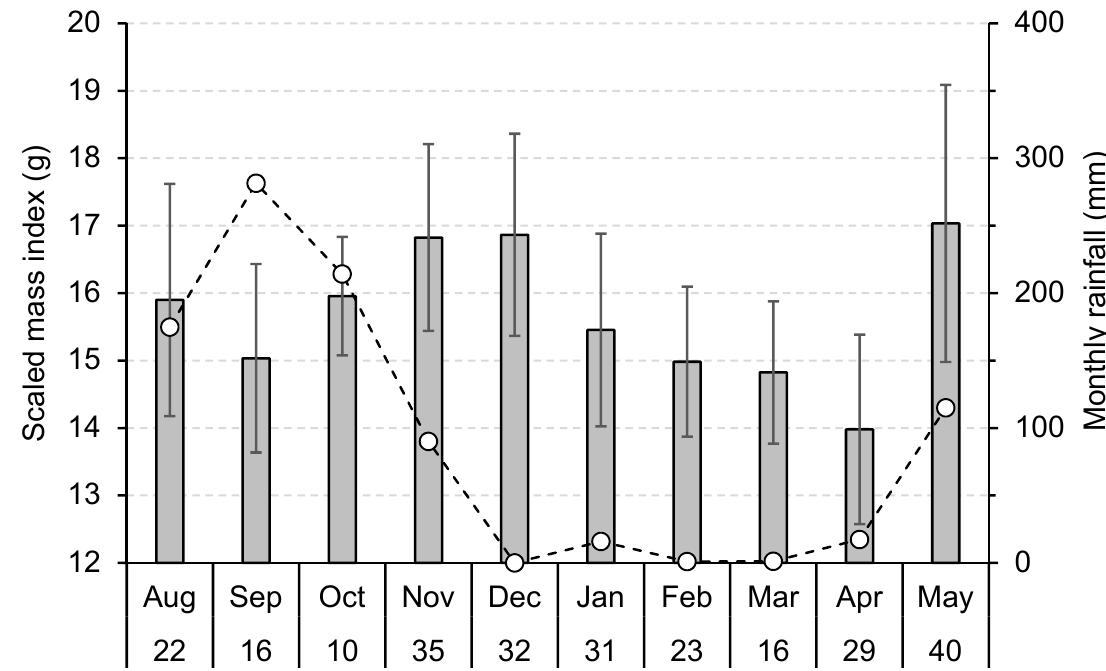
Figure 4. Scaled mass index (SMI) of mature male Chaerephon plicatus ( n = 254) in Battambang province (north-western Cambodia) from August 2015 to May 2016 (bars) in relation to monthly rainfall for the same period (broken line). Bars represent means, whiskers represent standard deviations and values below the graph are monthly sample sizes. Note the y-axis is truncated to improve resolution.